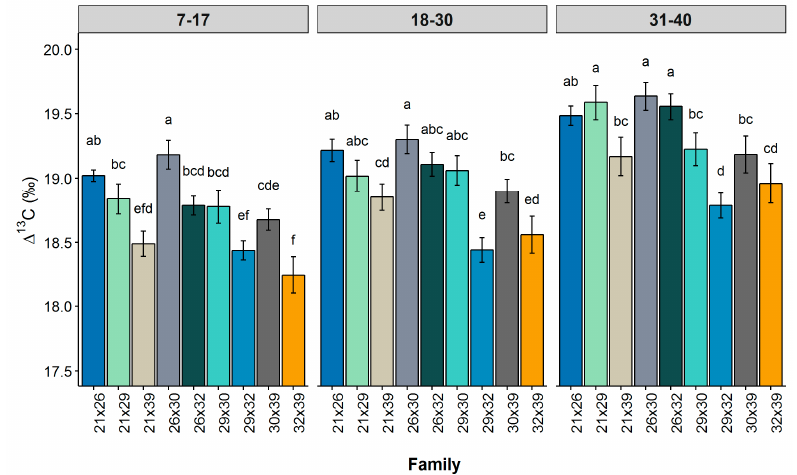
Figure 4. Mean (± standard error (SE)) ∆ 13 C (‰) varied significantly among families for early, intermediate and late growth ages. Means with the same letter within each time period are not significantly different from each other as indicated by Tukey HSD post-hoc test ( α = 0.05).